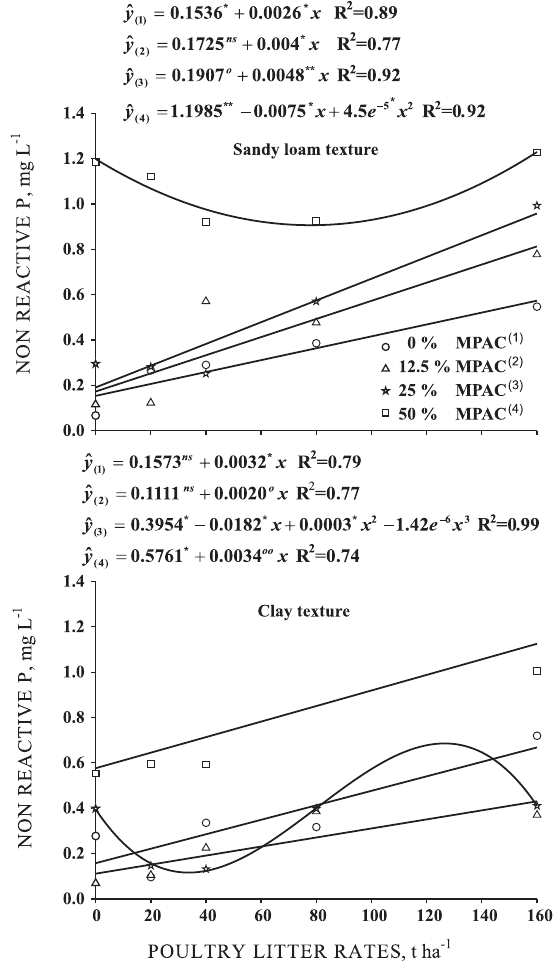
Figure 2. Concentrations of non-reactive P (Po) in leachate from two Latosols of sandy loam and clay texture, prefertilized with increasing rates of mineral P, as related to poultry litter rates applied in the top ring. ns , oo , o , *, **: not significant and significant at 15, 10, 5 and 1 %,